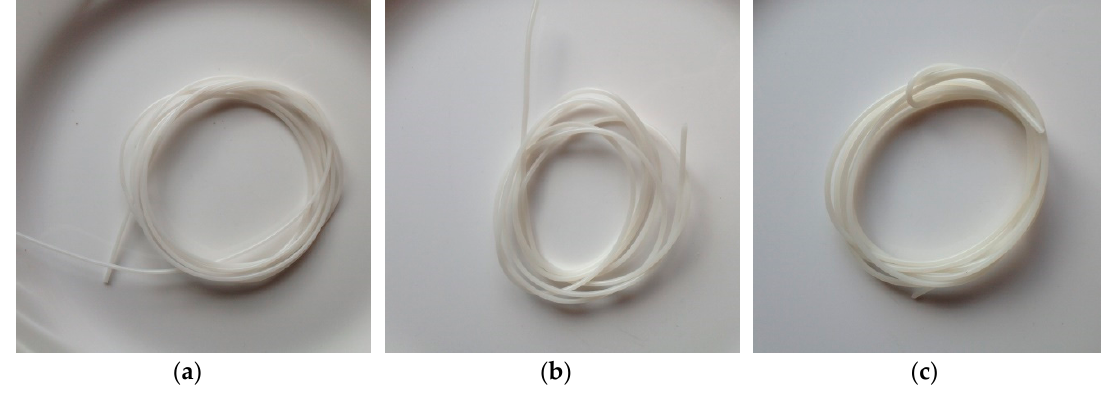
Figure 1. Filaments produced by hot melt extrusion (HME) ( a ) Blend 4; ( b ) Blend 4A and ( c ) Blend 4B.